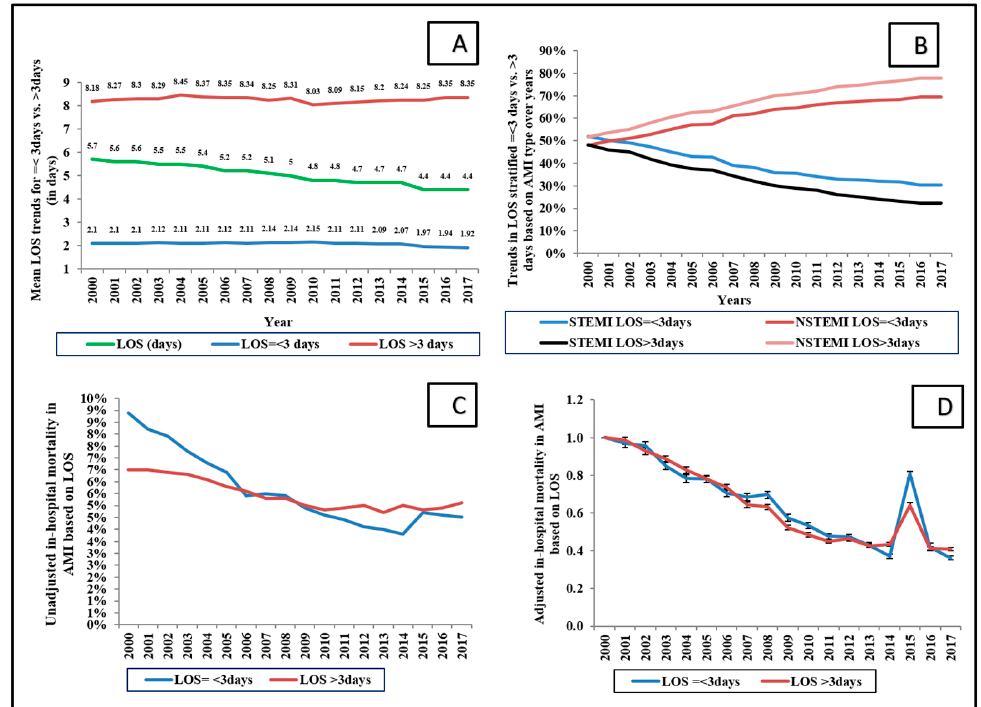
Figure 1. Trends in overall length of stay in acute myocardial infarction. Legend: ( A ) Unadjusted temporal trends in mean length of stay in AMI ( p < 0.001 for trend over time); ( B ) unadjusted length of stay stratified based on type of AMI and LOS ( ≤ 3 days vs. >3 days) in the hospital in AMI; ( C ): unadjusted in-hospital mortality in AMI based on LOS; ( D ): adjusted in-hospital mortality in AMI based on LOS (with 2000 as the referent); p < 0.001 for trend over time. Adjusted for age, sex, race, income status, comorbidity, primary payer, hospital region, hospital location, teaching status, hos- pital bed size, type of MI, cardiogenic shock, cardiac arrest, acute organ failure, atrial fibrillation, atrial flutter, coronary angiography, percutaneous coronary intervention, coronary artery bypass grafting, pulmonary artery catheterization, mechanical circulatory support, invasive and non-inva- sive mechanical ventilation, and acute hemodialysis ( p < 0.001 for trend over time). Abbreviations: AMI: acute myocardial infarction, LOS: length of stay. LOS in a STEMI population decreased, whereas it increased in a NSTEMI population (Figure 1B). When stratified by patient characteristics, LOS remained steady except for a marginal uptrend in LOS in the white and black race categories (Figure 2). There was a